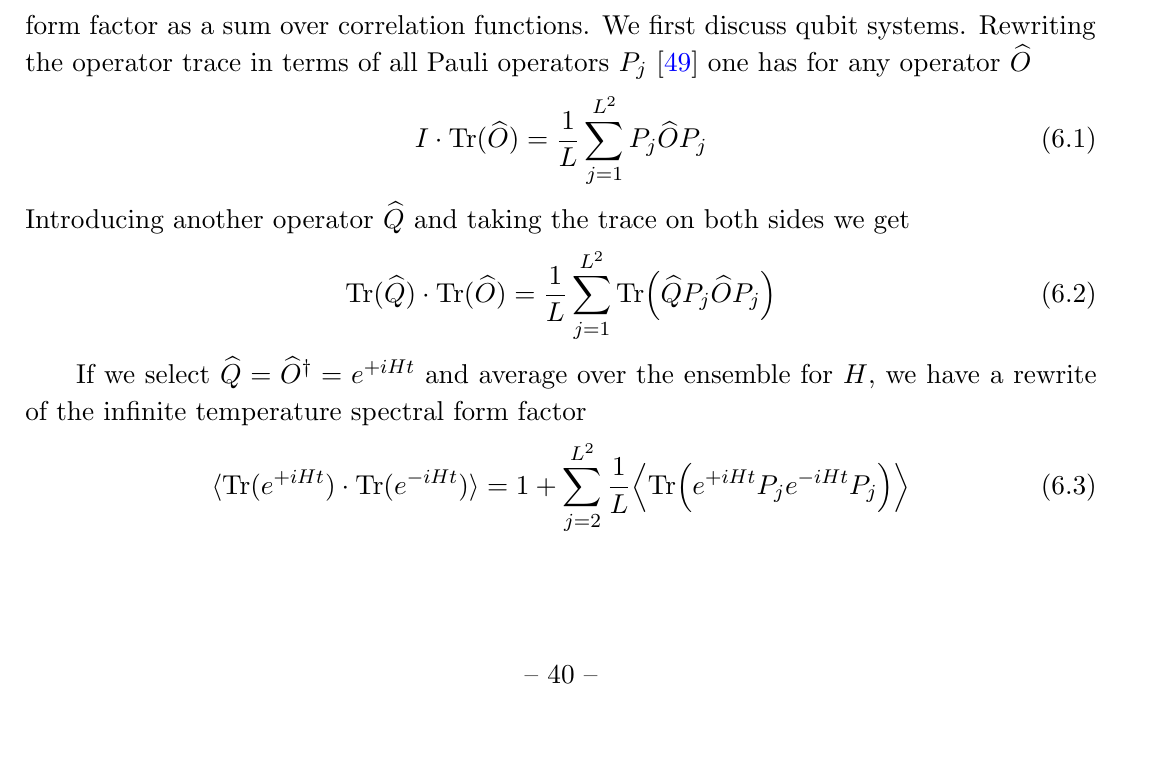
Figure 23 . Numerical results for local XXZ random circuit. [Top-Left] The eigenvalues of Q loc ;r for r = 0 ; 1 ; 2 ; 3 ; 4 for N = 8. The second largest eigenvalues take the same value. [Top-Right] The u (1 ; t ) for r = 0 ; 1 ; 2 ; 3 ; 4 at N = 8. They all converge to the same exponential decay in late times. [Bottom] The spectral form factors for several values of N in the largest sector, where r = N= 2 (or S z =